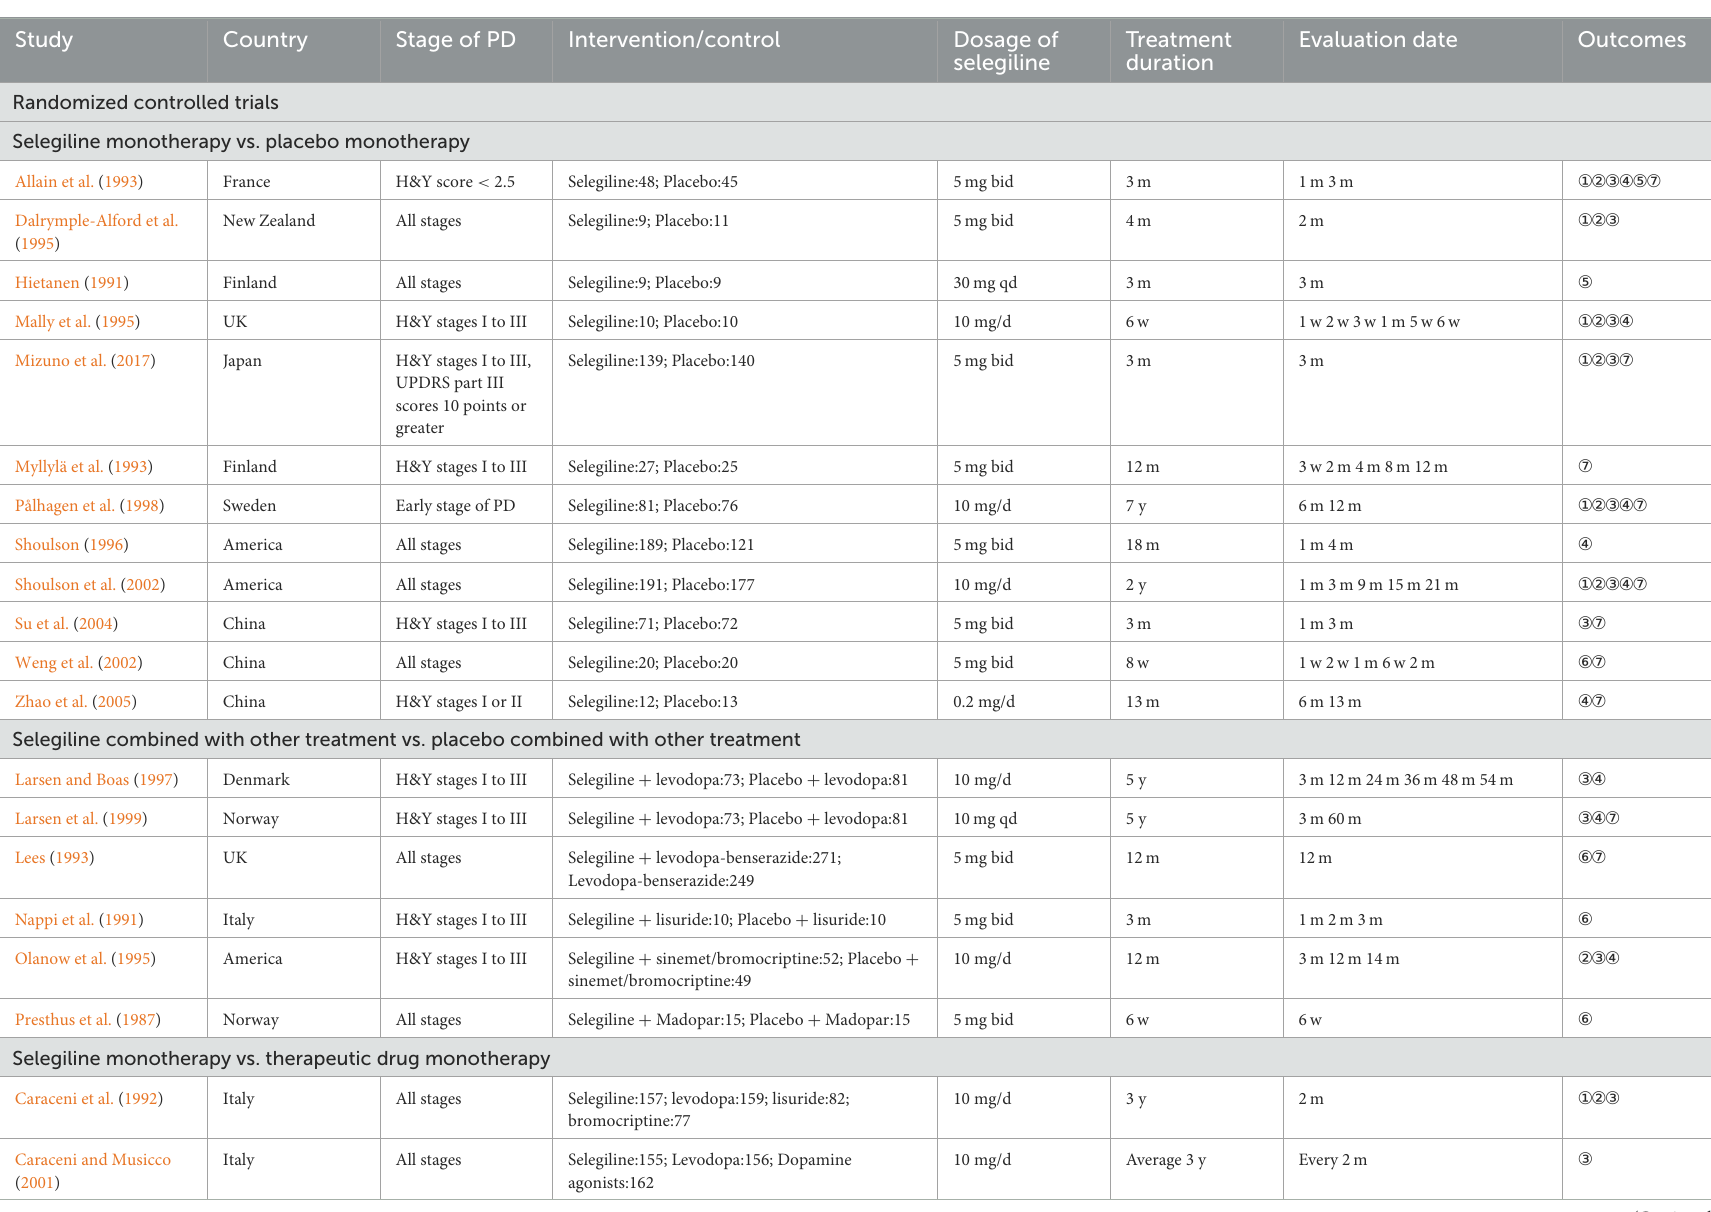
TABLE 1 Characteristics of included